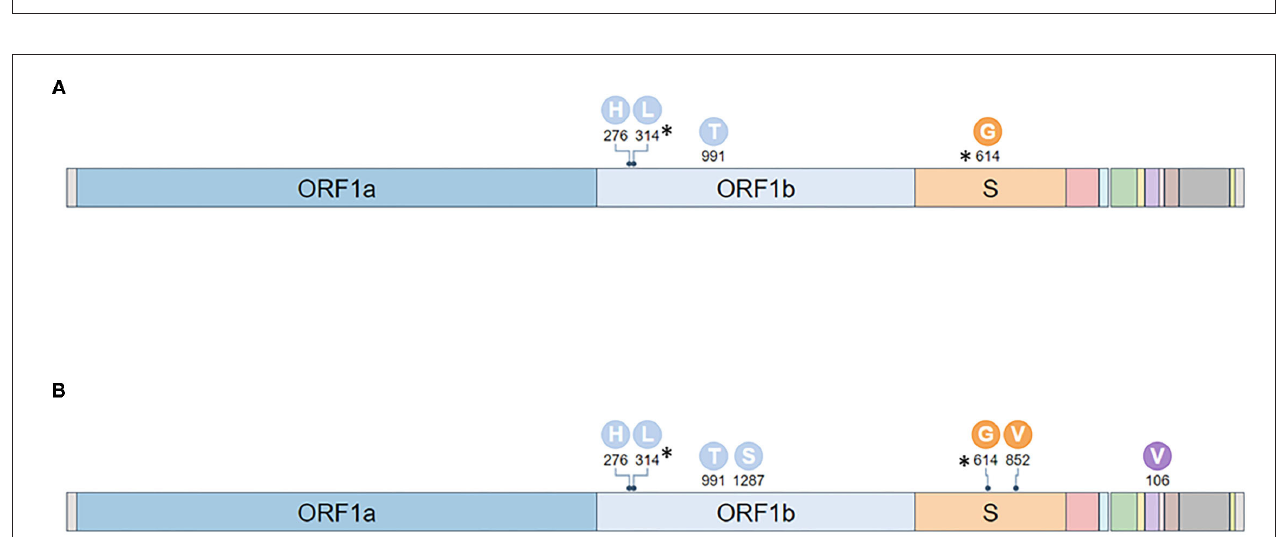
FIGURE 1 | Timeline of symptom onset, molecular diagnosis, and sequencing of specimens.